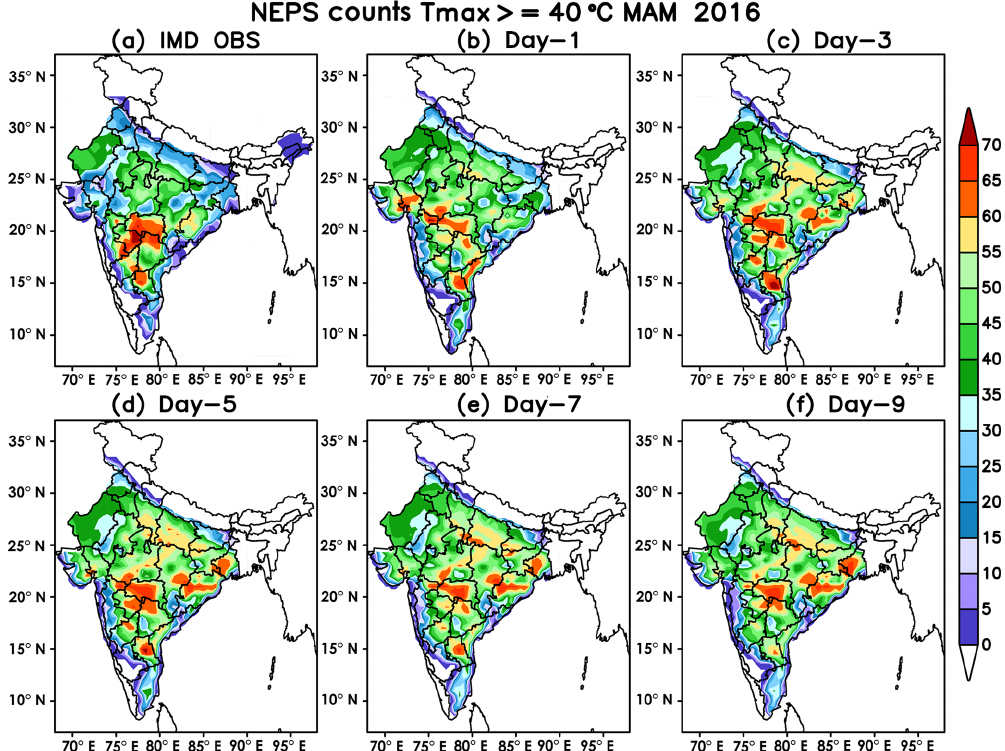
Figure 3. Spatial distribution of observed (a) and NEPS forecasts (b–f) number of days with T max ≥ 40 ◦ C during the period of March to May 2016 (NEPS stands for the NCMRWF ensemble prediction system; observed data from India Meteorological Department and forecast data from NCMRWF). Regions with over 60 days of T max ≥ 40 ◦ C are indicated in orange and red. In the observations (a) this is confined to a small part over peninsula. The NEPS forecasts (b–f) show T max ≥ 40 ◦ C widespread over northern and eastern parts of India. NEPS forecasts (b–f) have a better agreement with the observations (a) compared to NCUM forecasts (Fig. 2b–f).